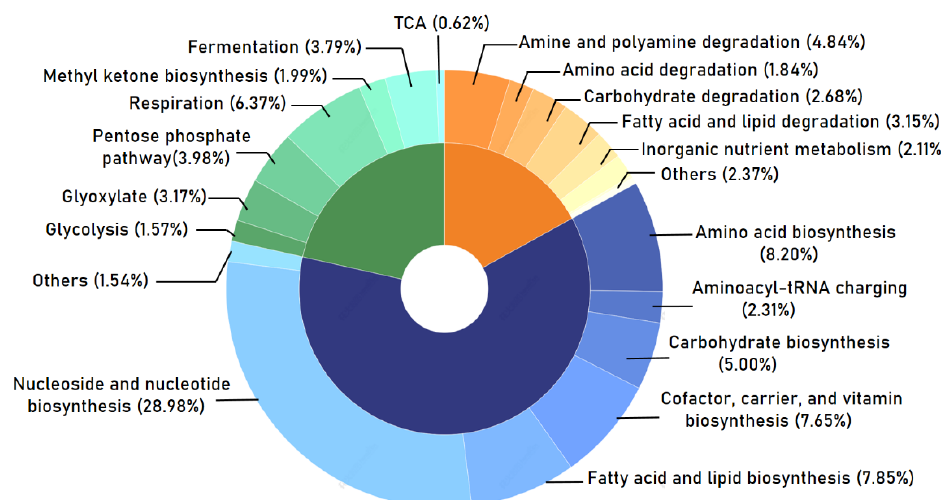
Figure 4. Functional assignments of the entire fungal microbiome coexist with K. veneficum. Gene functions were predicted from rDNA ITS region-based fungal compositions using the PICRUSt algorithm to draw inferences from the MetaCyc metabolic pathway database. Relative signal intensity normalized by the number of genes for each indicated metabolic pathway. The whole fungal microbiome generally performs the broad functions of biosynthesis (61.52%; blue), degradation/utilization/assimilation (16.99%; orange), and the generation of precursor metabolites and energy (21.49%; green).